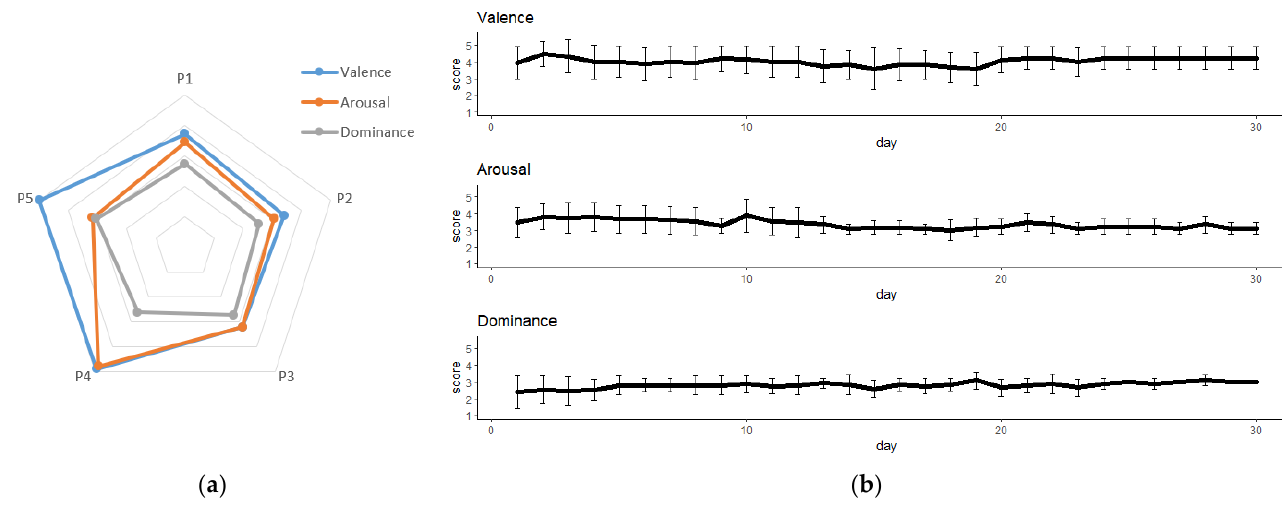
Figure 8. SAM test results: ( a ) mean score of each patient; ( b ) mean score of all patients.